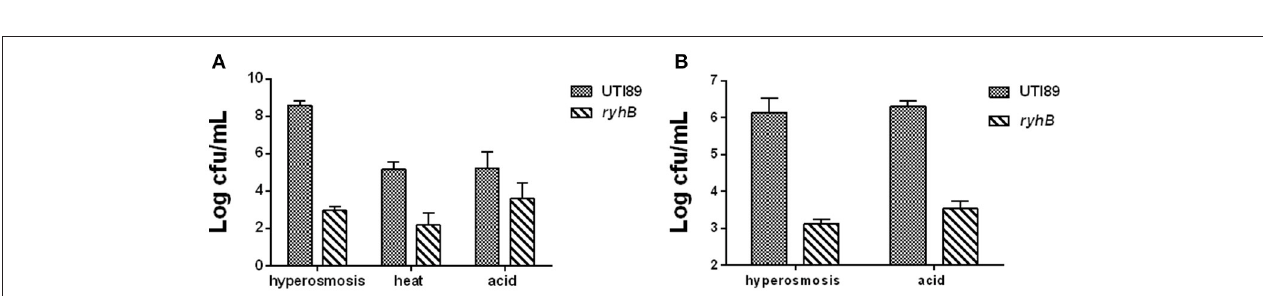
FIGURE 2 | Hypersensitivities of the 1 ryhB mutant to stresses. (A) Susceptibilities of the stationary phase bacteria ( ∼ 10 9 CFU/mL) were determined after exposure to hyperosmosis (NaCl, 4M) for 3 d, heat (55 ◦ C) for 3h or acid (pH 3.0) for 12h. (B) Susceptibilities of the exponential phase bacteria ( ∼ 10 8 CFU/mL) were determined after exposure to hyperosmosis (NaCl, 4M) or acid (pH 3.0) for 3h. Error bars show standard variations in CFU between at least three independent experiments.